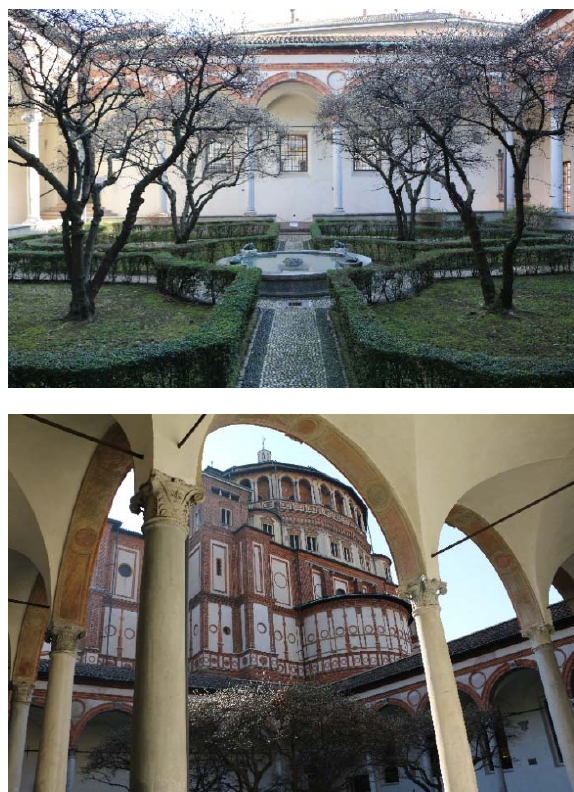
Figure 1. The Chiostro delle Rane and a view of the Lantern of the